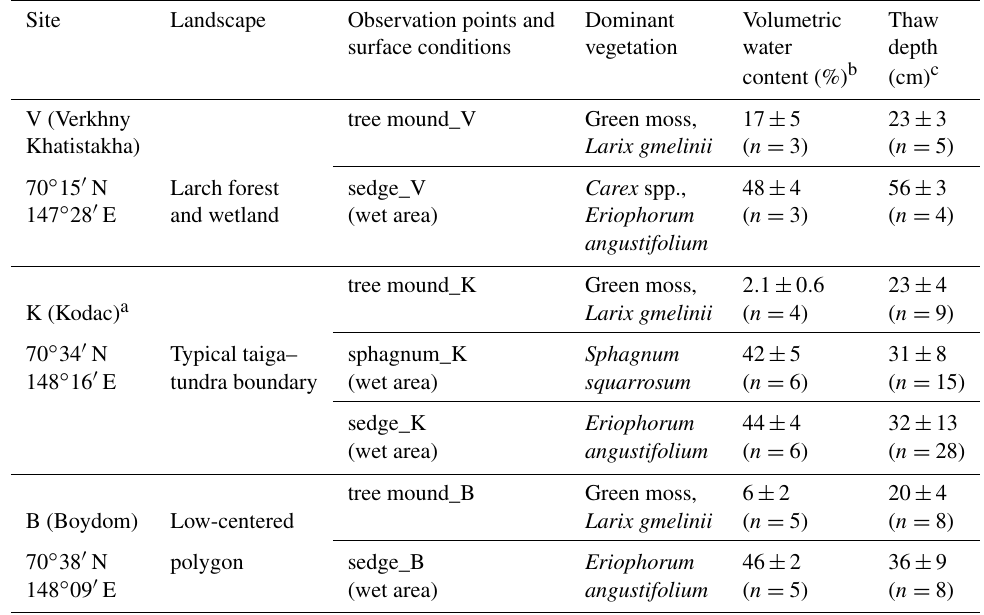
Table 1. Observation points of chamber CH 4 flux. Concentration and isotopic compositions of dissolved CH 4 were also observed in the following wet areas.